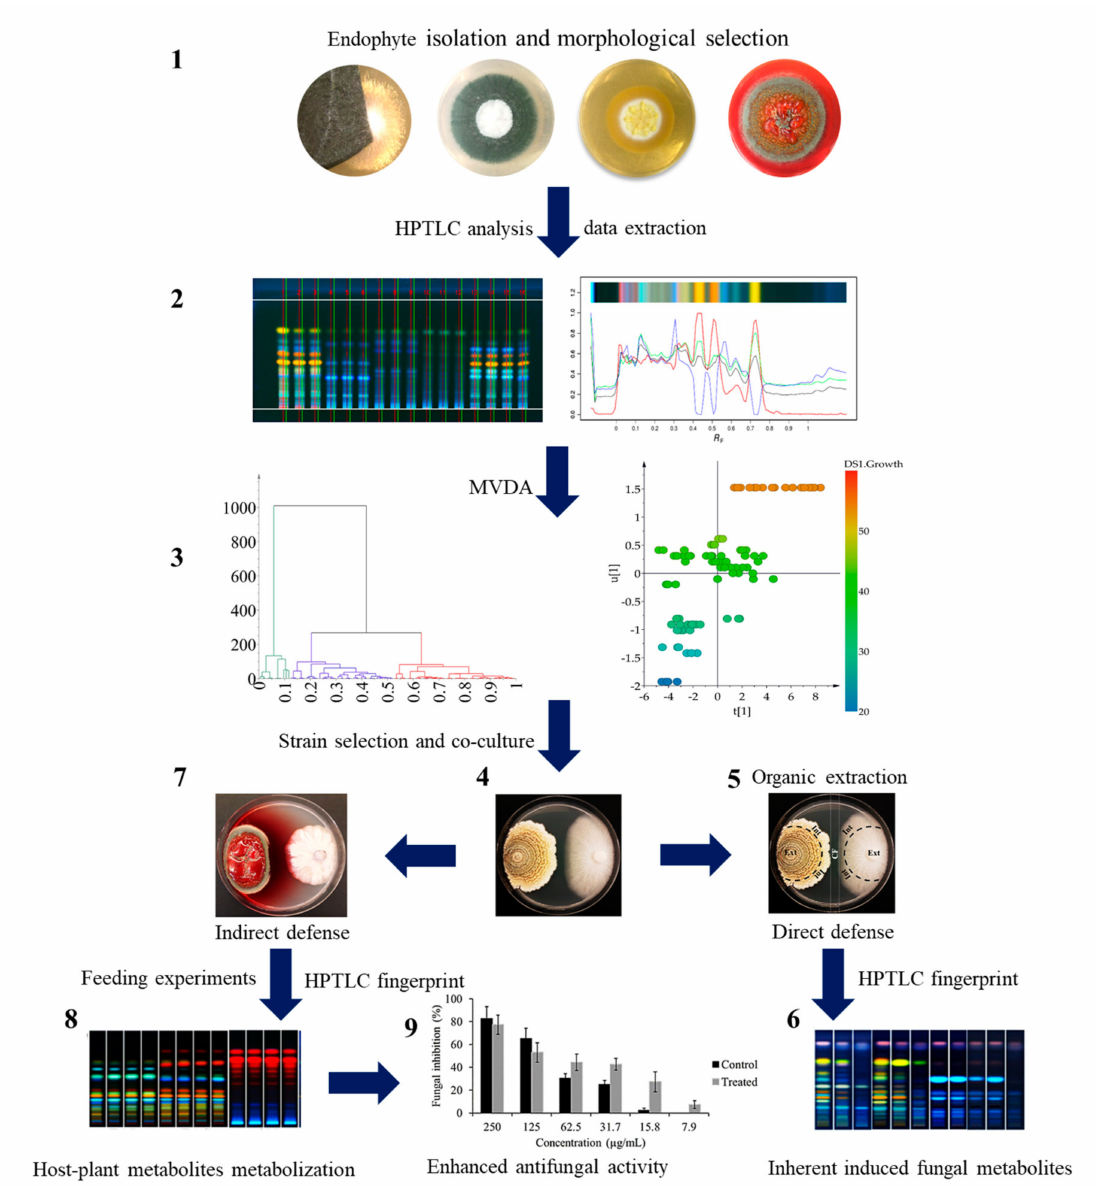
Figure 1. HPTLC-assisted selection of bioactive fungal endophytic strains. ( 1 ), Fungal isolation on solid medium and strain selection based on morphological colony features. ( 2 ), High performance thin layer chromatography (HPTLC) analysis, data extraction and curation. ( 3 ), Multivariate data analysis (MVDA) from HPTLC analysis, correlation to fungal characters (colony size), and strain selection based on chemical and biological correlation. ( 4 ), Co-culture bioassays of selected fungal strains. ( 5 ), Determination and selection of fungal endophytes with direct defensive (antifungal) capability against fungal pathogens. ( 6 ), HPTLC fingerprint analysis from different zones of co-cultures to determine the involvement of constitutive and/or induced metabolites on fungal defense. ( 7 ), Selection of fungal endophytes without antifungal effects. ( 8 ), Feeding host-plant metabolites to no active fungal endophytes and HPTLC fingerprinting analysis to monitor new potential metabolic production. ( 9 ), Determination of the fungal activity enhancement of fungal endophytic extracts after host-plant metabolization. The error bars indicate standard error of the average antifungal percentage values ( n =